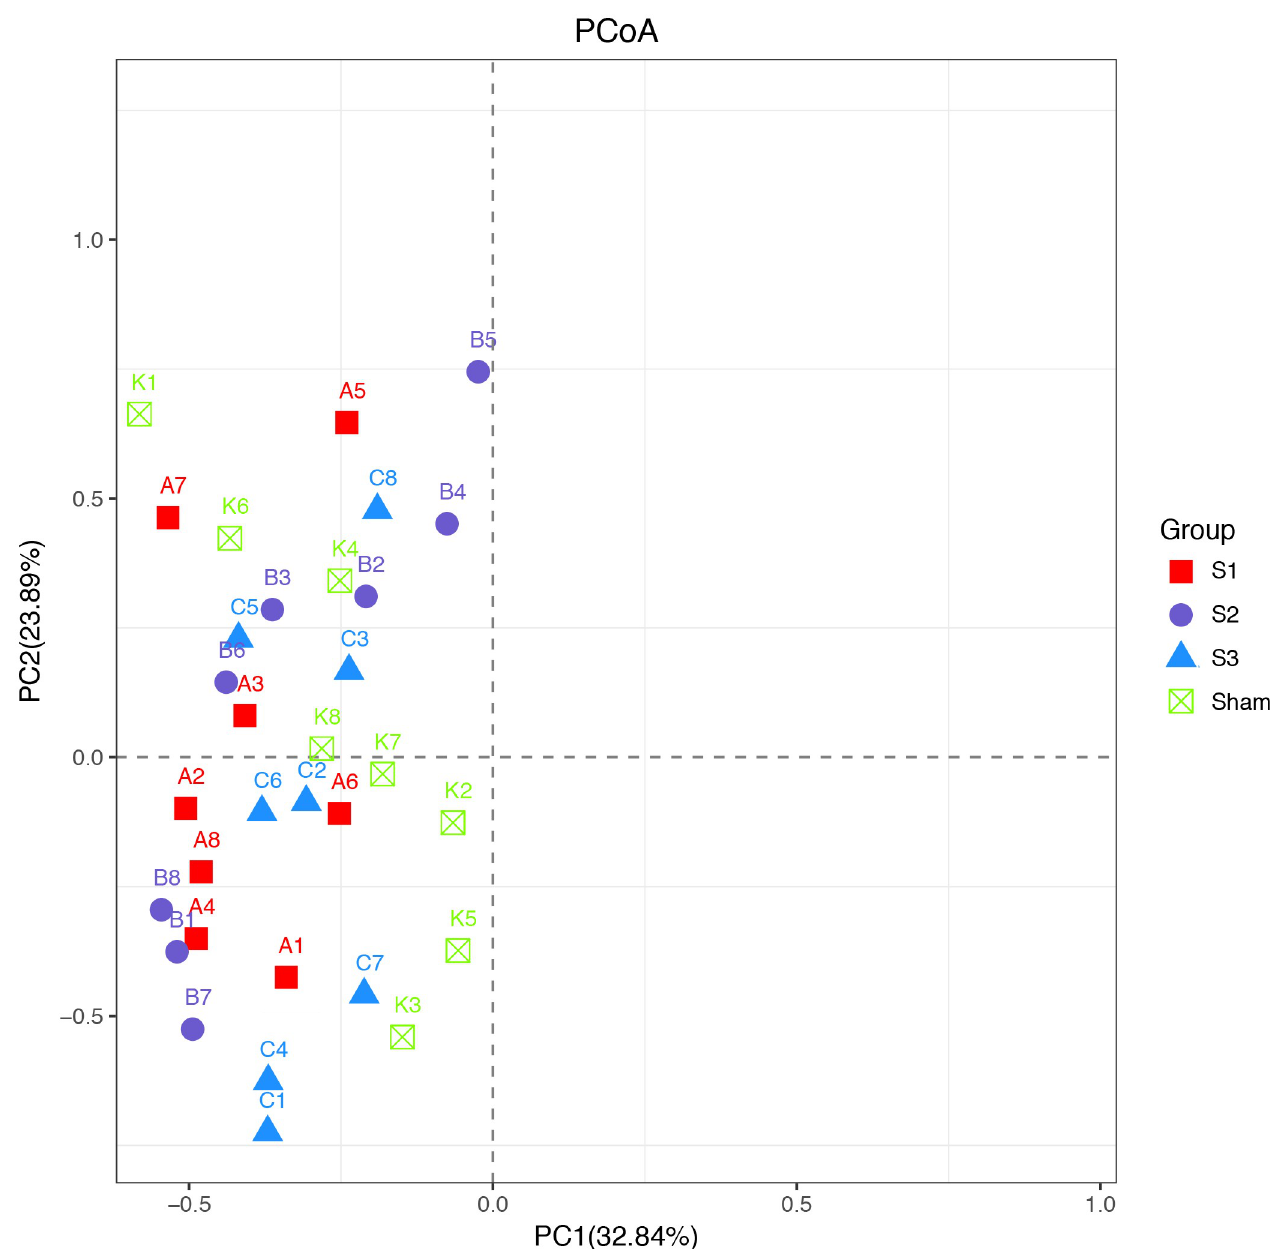
Fig 3. Principal coordinate analysis (PCoA) analysis before